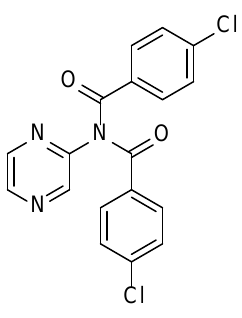
Figure 2. Structure of N , N -diacylated product 1l-SP .